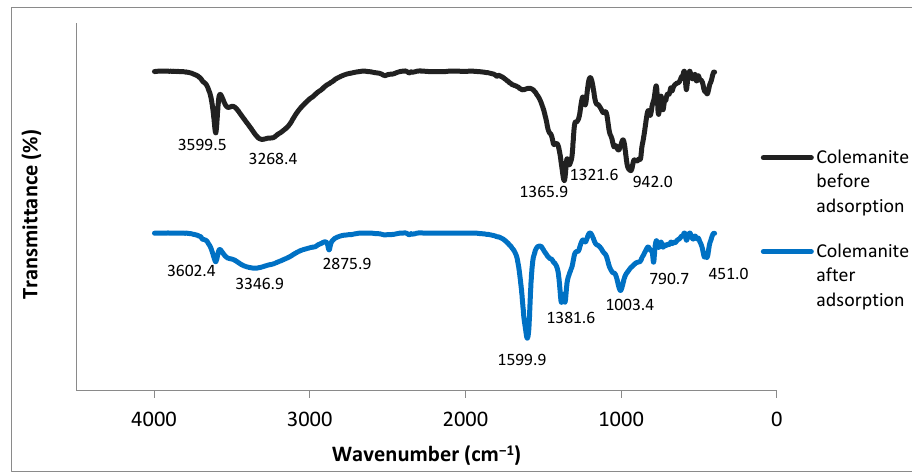
Figure 7. FTIR spectra of colemanite before and after adsorption of fluoroquinolones.